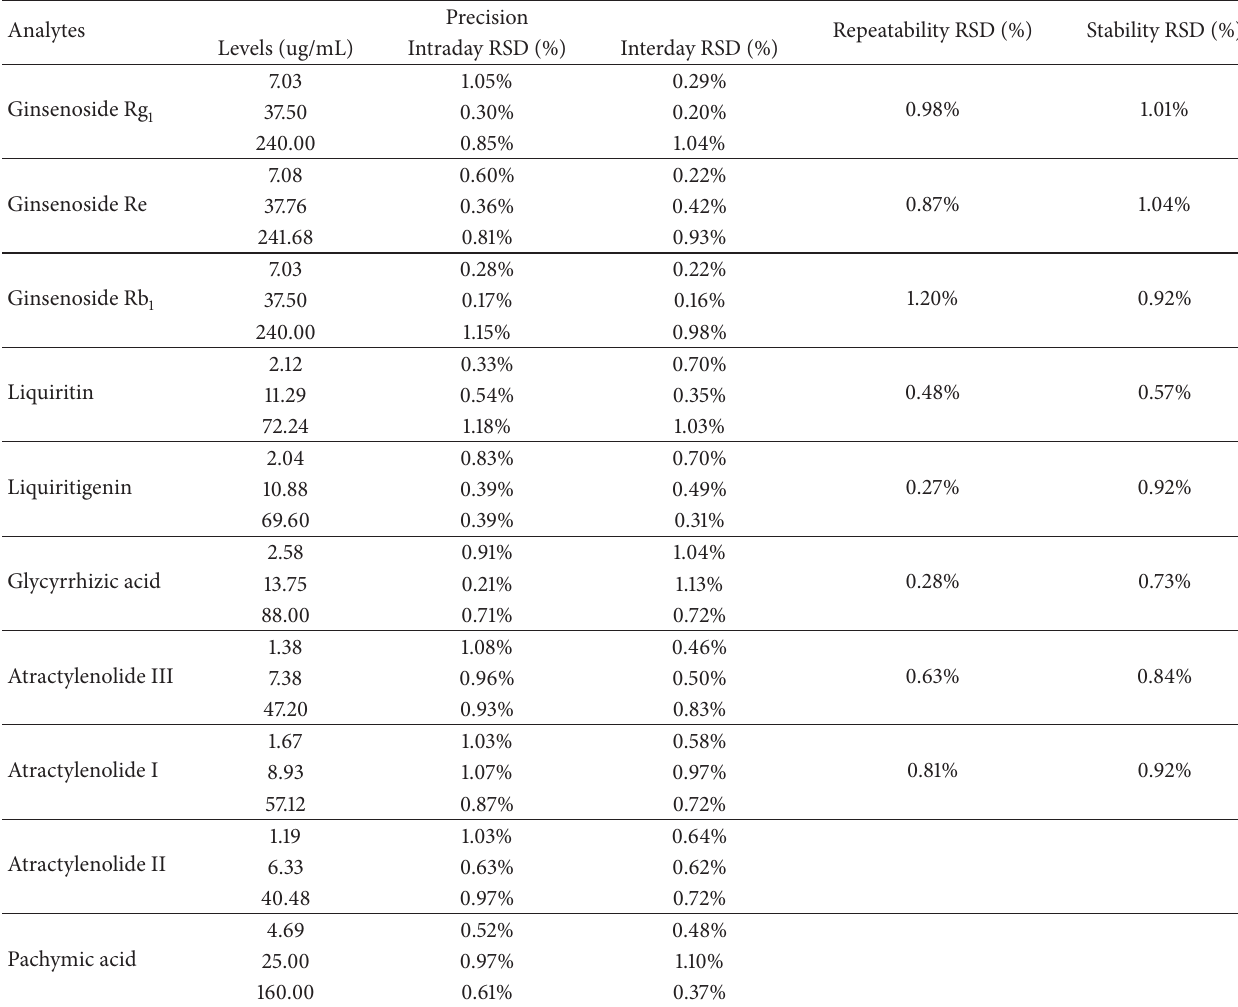
Table 2: Precision, repeatability, and stability of ten compounds in SJZT ( 𝑛 = 6